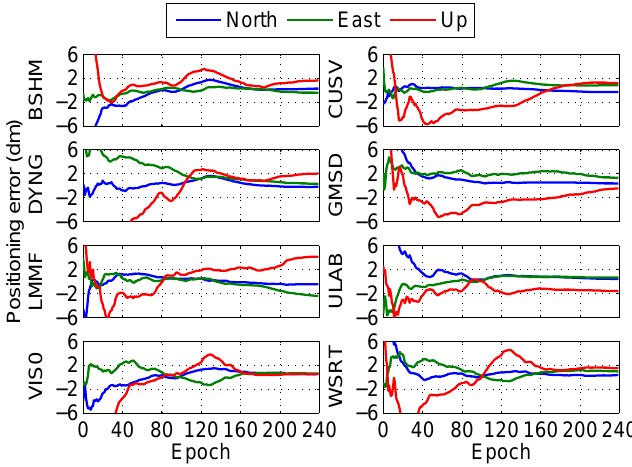
Figure 15. Float positioning error in different stations in the real-time